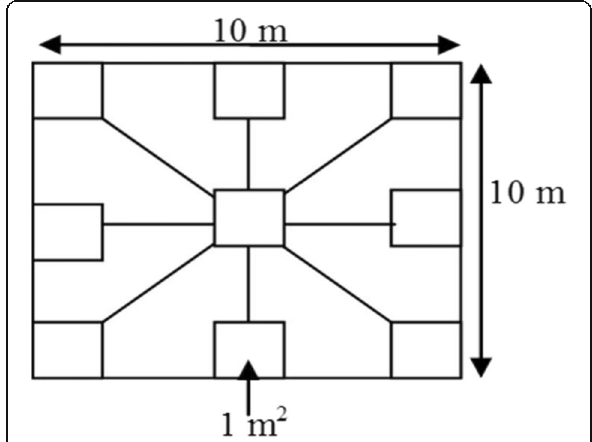
Fig. 2 Diagram illustrating quadrat position in a 10 m × 10 m sampling site for recording data on species composition, species richness, basal cover, biomass yield, and soil properties under three S. obtusifolia invasion levels (non-invaded, lightly invaded, and heavily invaded) at two locations in northern